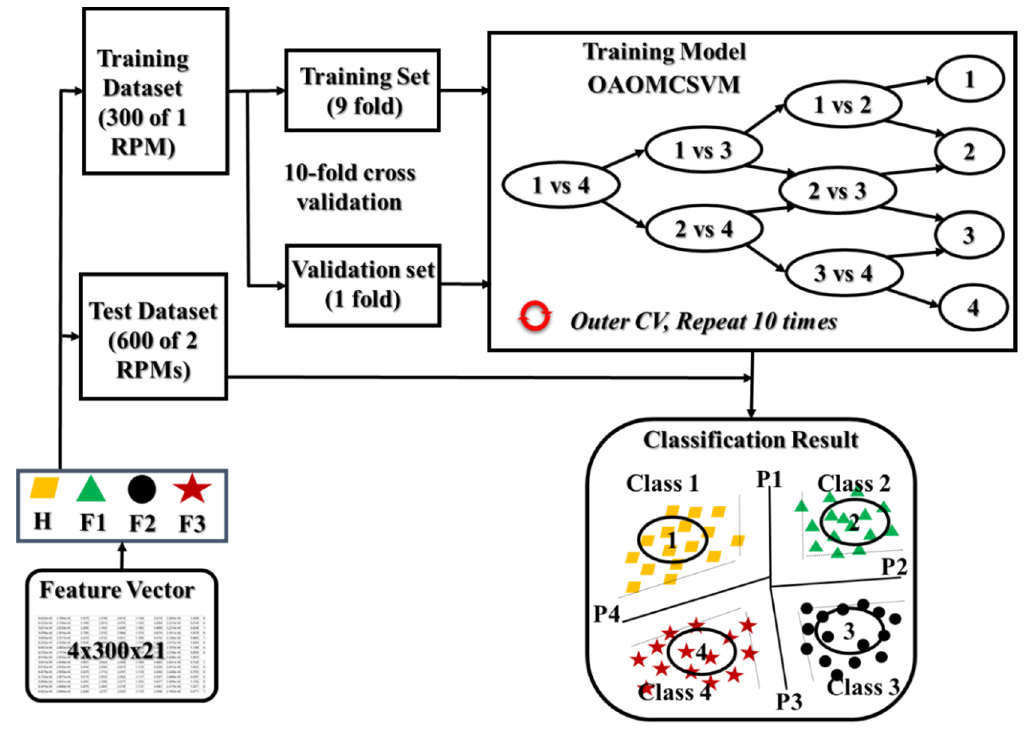
Figure 11. The classification methodology of OAOMCSVM.